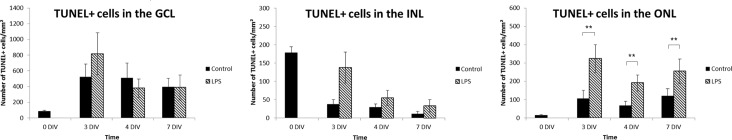
Quantification of apoptotic cells.The graphs show numbers of TUNEL-positive cells in the GCL, INL and ONL, in controls- and LPS-treated groups. ANOVA analysis was performed for comparison between the LPS treated group and the control groups. Data are given as mean±StDev (n = 4-6/group), **p<0.01.